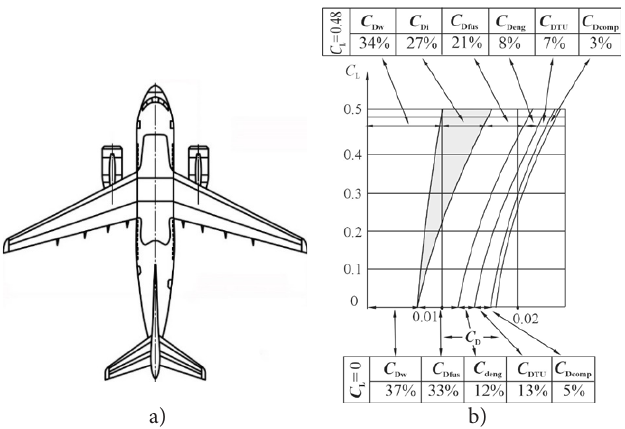
Figure 3. Calculated estimate of the airplane drag factor components with a sweep along the leading edge of 28 and a taper ratio of η = 1/3.5: (a) Aircraft plan view; (b) Graph and values for drag components